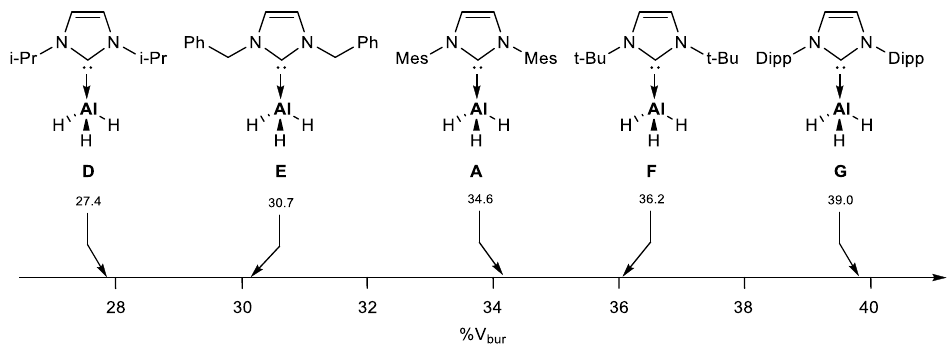
Figure 2. Reported NHC-alanes [5, 28 −3 1] vs. percent buried volume (% V bur